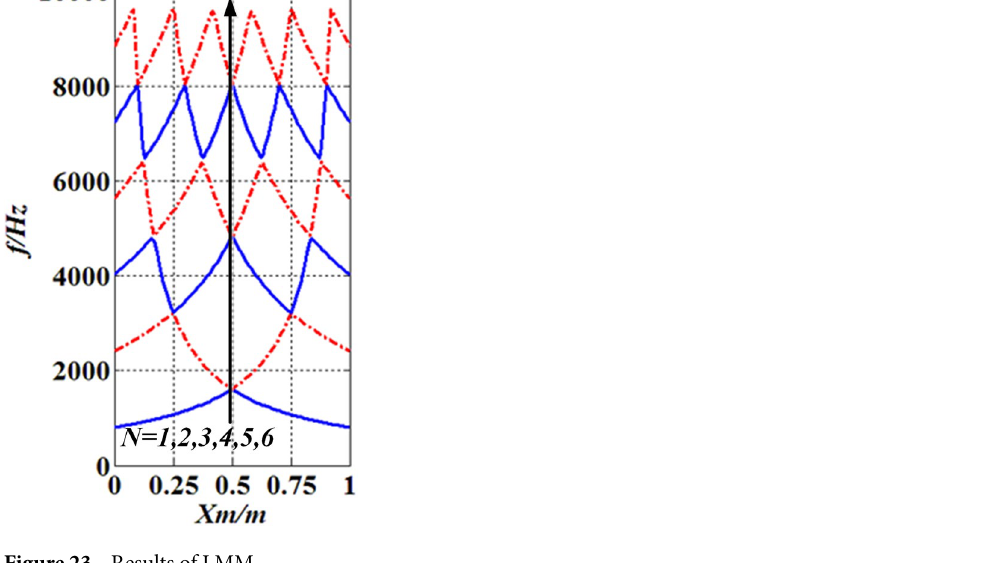
Figure 23. Results of